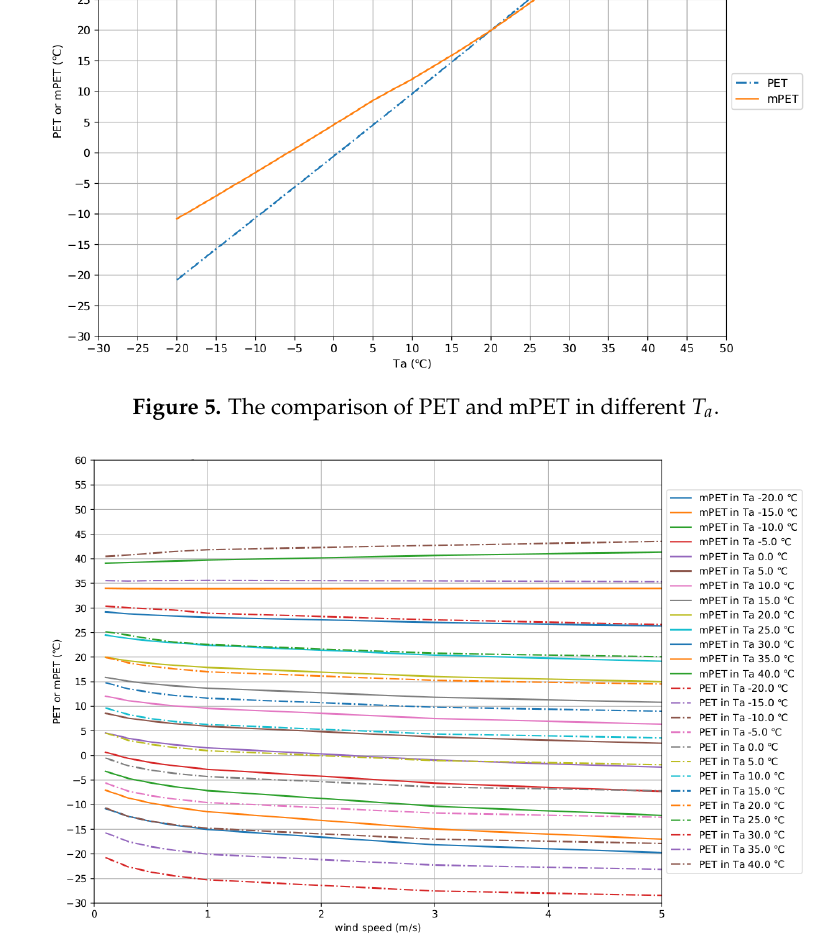
Figure 6. The comparison of PET and mPET in different T a and v